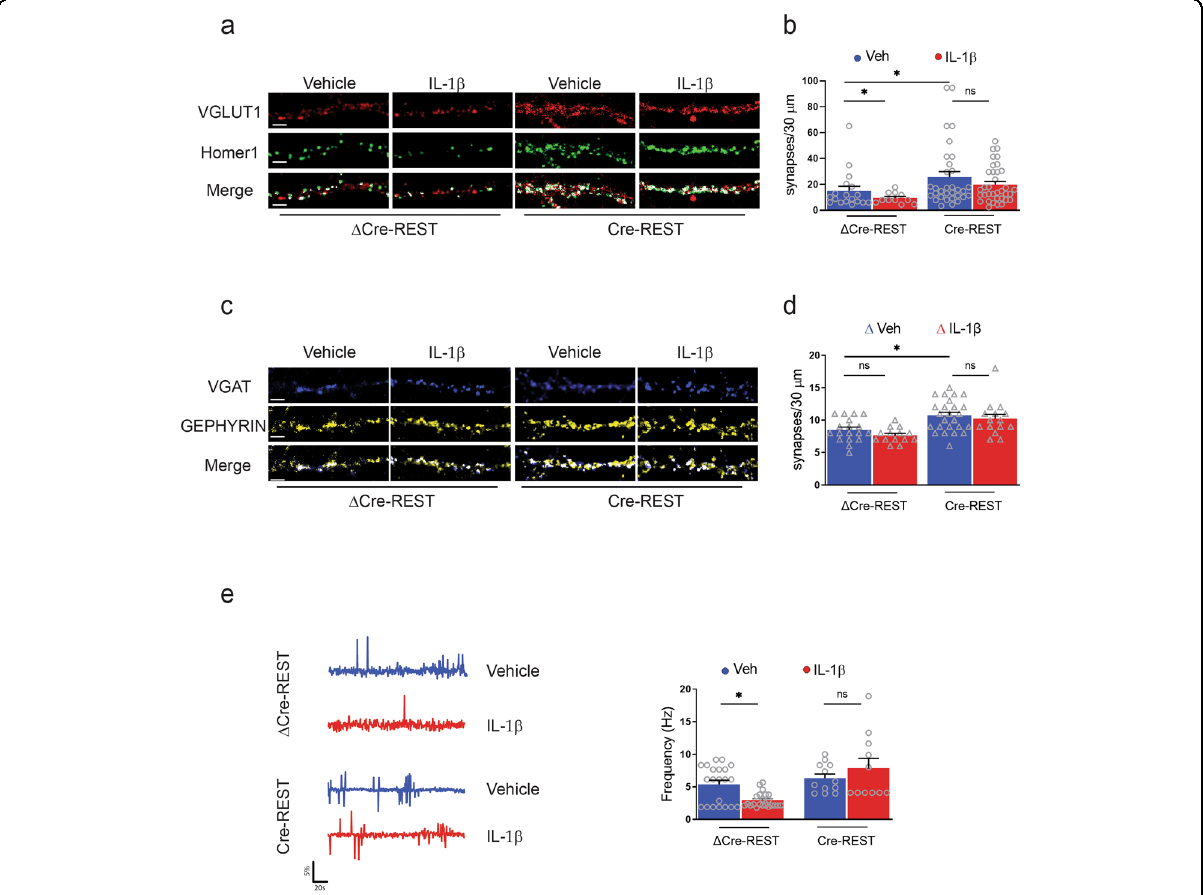
Fig. 6 REST deletion occludes the IL-1 β -mediated decrease in the density of excitatory synapses. a , b Excitatory synapses. a Representative images of excitatory synaptic boutons in proximal dendrites from Δ Cre- and Cre-infected neurons treated with either vehicle or IL-1 β for 20 min at 7 DIV and analyzed at 14 DIV. Excitatory synapses were identi fi ed by double immunostaining with VGLUT1/Homer1. The merged panels highlight the double-positive puncta (white) corresponding to bona fi de synapses. b Quanti fi cation of the linear density of inhibitory synapses expressed as the mean number of excitatory boutons counted on 30-µm dendritic branches starting from the cell body in Δ Cre- and Cre-infected neurons treated with vehicle (veh; blue bars) or IL-1 β (red bars). c , d Inhibitory synapses. c Representative images of inhibitory synaptic boutons identi fi ed by double immunostaining with VGAT/Gephyrin under the same experimental conditions shown in a . d Quanti fi cation of the linear density of inhibitory synapses expressed as the number of inhibitory boutons counted on 30-µm dendritic branches starting from the cell body in Δ Cre- and Cre-infected neurons treated with vehicle (veh; blue bars) or IL-1 β (red bars). Scale bars, 6 µm. e Representative traces (left) and frequency of calcium oscillations (right) in Δ Cre-REST and Cre-REST transduced cortical neurons treated with either vehicle (blue traces) or IL-1 β (red traces) for 20 min at 7 DIV. Recordings were performed at 14 DIV. Peaks with at least 2% of difference with respect to the baseline were considered and their frequency was calculated as total number of signi fi cant peaks over the recording time. Bar graphs in b , d , e show mean ± sem with superimposed individual points from independent coverslips prepared from at least n = 3 distinct preparations. * p < 0.05; two-way ANOVA/Bonferroni ’ s